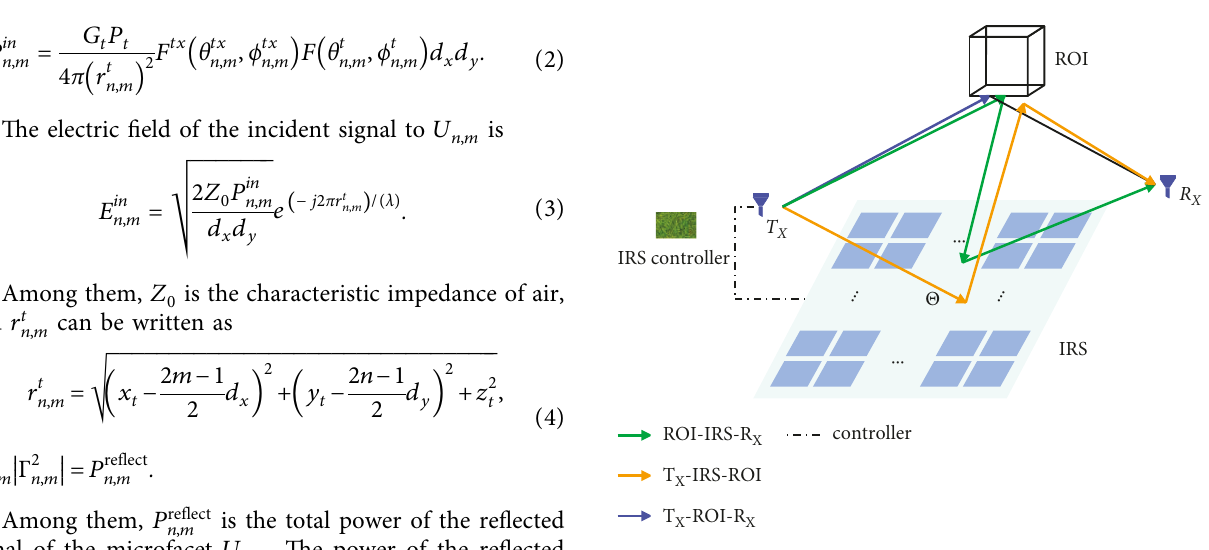
Figure 3: Imaging system model (centralized IRS